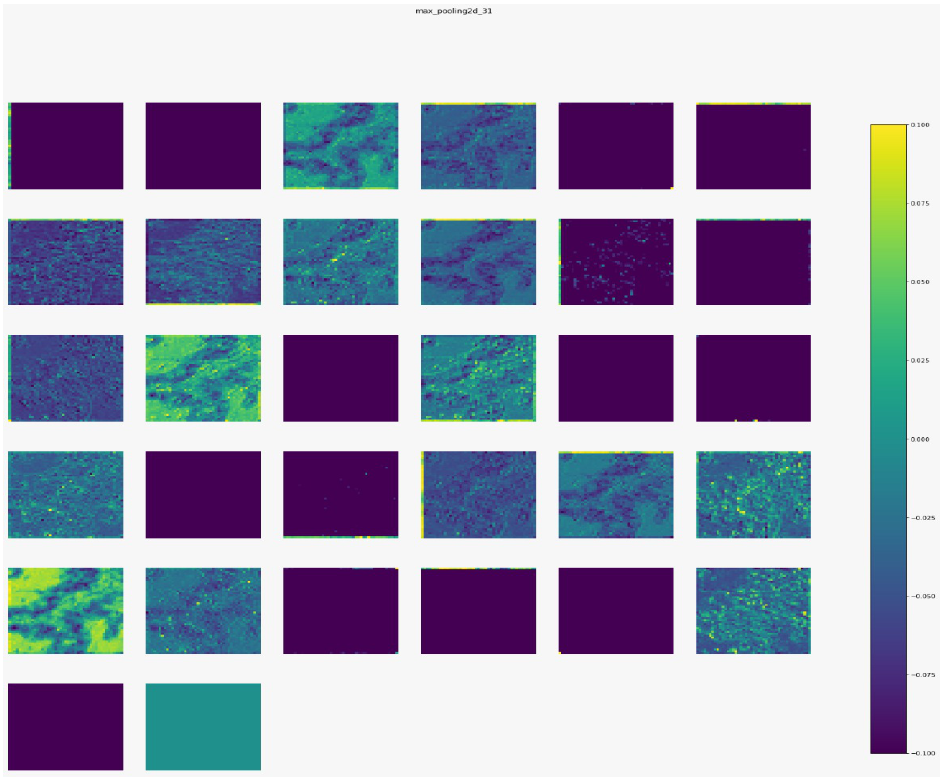
Figure 8. The output of the first Max pooling